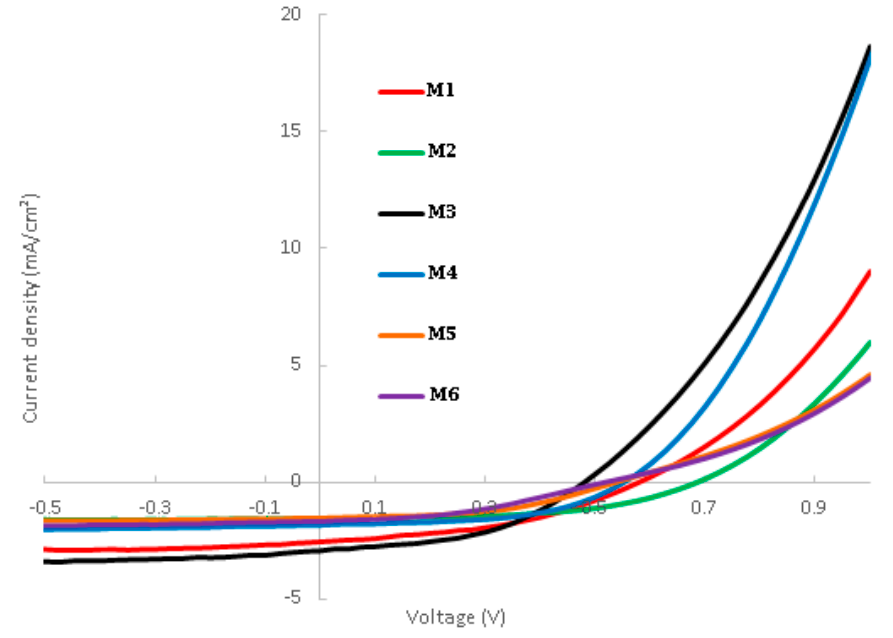
Table 3. Photovoltaic parameters of ssDSSCs sensitized with chlorins M1–M6 and D102 under simulated solar emission (100 mW·cm − 2 , AM 1.5G): short-circuit current density ( J SC ), open-circuit voltage (V OC ), fill factor (FF), and power conversion efficiency ( η ).